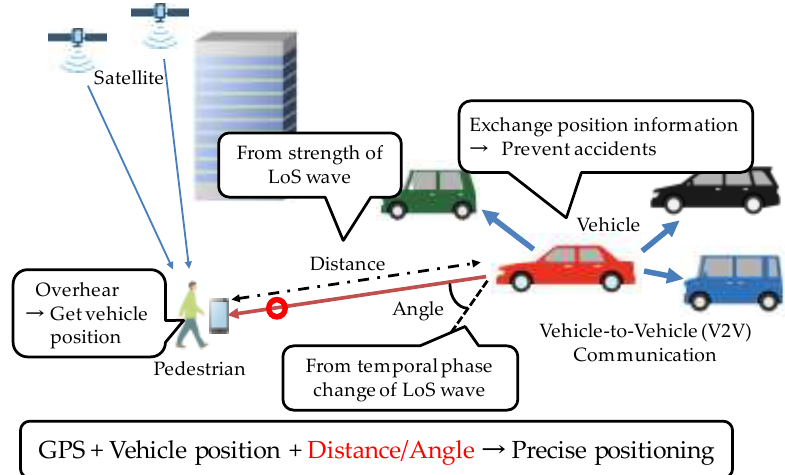
Figure 4. Overview of pedestrian positioning in the proposed method. GPS = Global Positioning System. Figure4. Overviewofpedestrianpositioningintheproposedmethod. GPS =